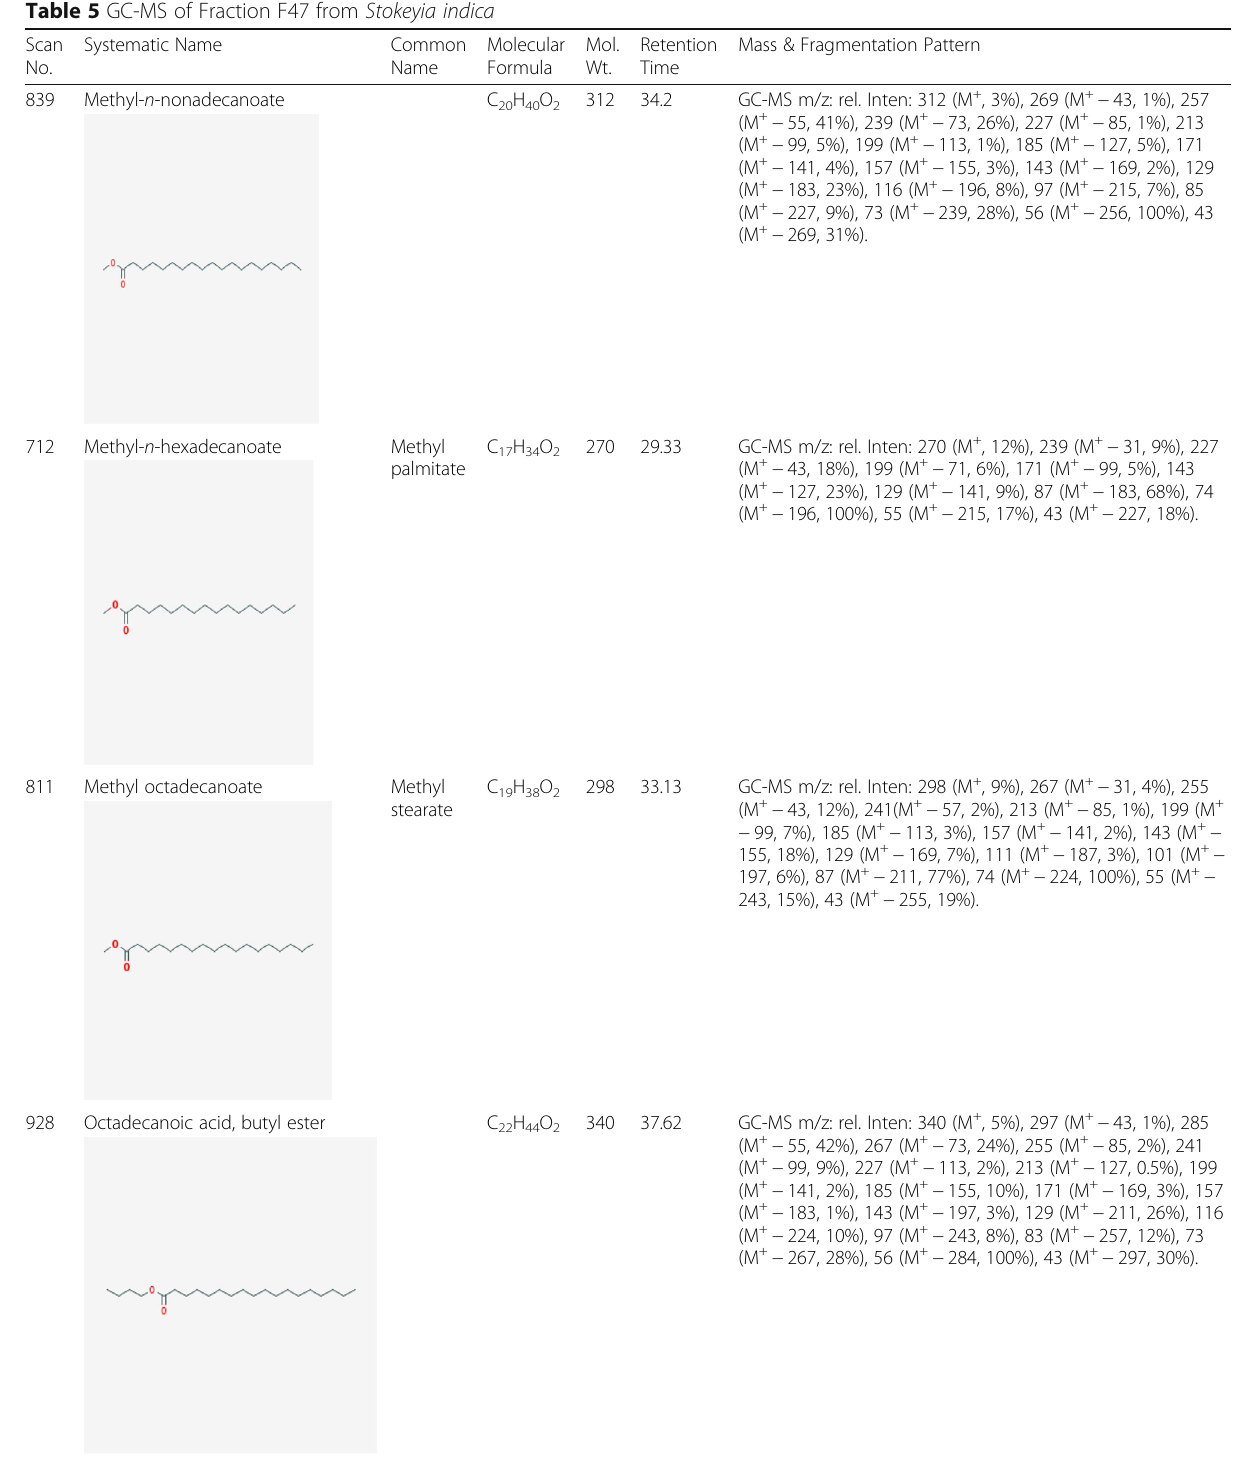
Table 5 GC-MS of Fraction F47 from Stokeyia indica Scan